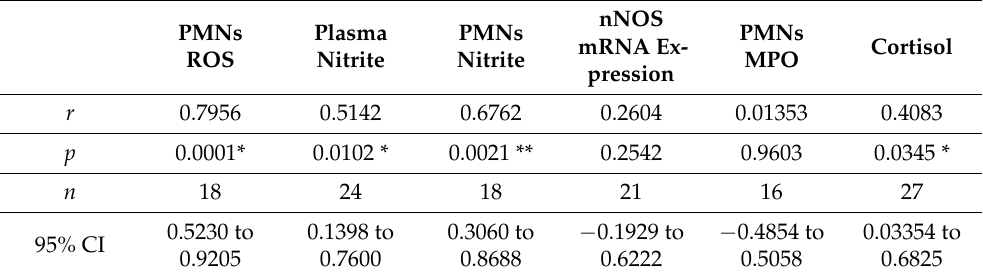
Figure 1. ( A ) Free radical generation (DCF mean fluorescence) in the PMNs of drug-naive depression patients, their first-degree relatives, and healthy volunteers (depression patients n = 20, first-degree relatives n = 18, healthy controls n = 18). DCF mean fluorescence in the PMNs of the healthy control was considered as 1 to calculate the fold change. F (2, 53) = 4.618; * p < 0.05. ( B ) Correlation in the ROS levels in the PMNs between patients and first-degree relatives. ( C ) MPO activity in the PMNs of drug-naive depression patients, their first-degree relatives, and healthy volunteers (depression patients n = 18, first-degree relatives n = 16, healthy controls n = 15). F (2, 46) = 4.274; * p < 0.05. ( A , C ) Data expressed as mean ± SEM. Table 3. Correlations between the investigated parameters of depression patients and their first- degree relatives. PMNs ROS